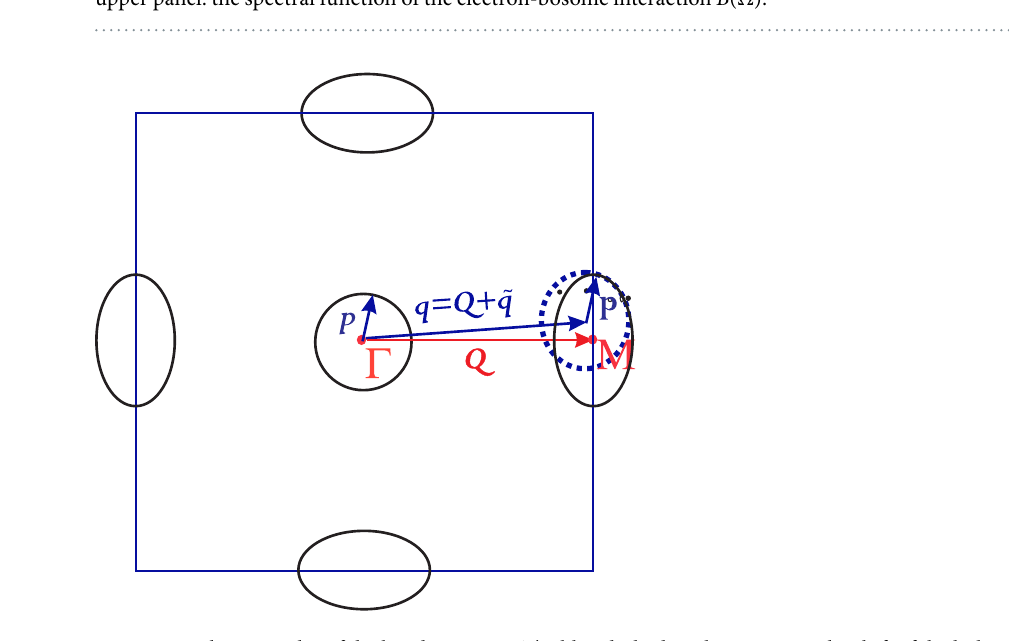
= 28 cm − 1 . Inset in the c